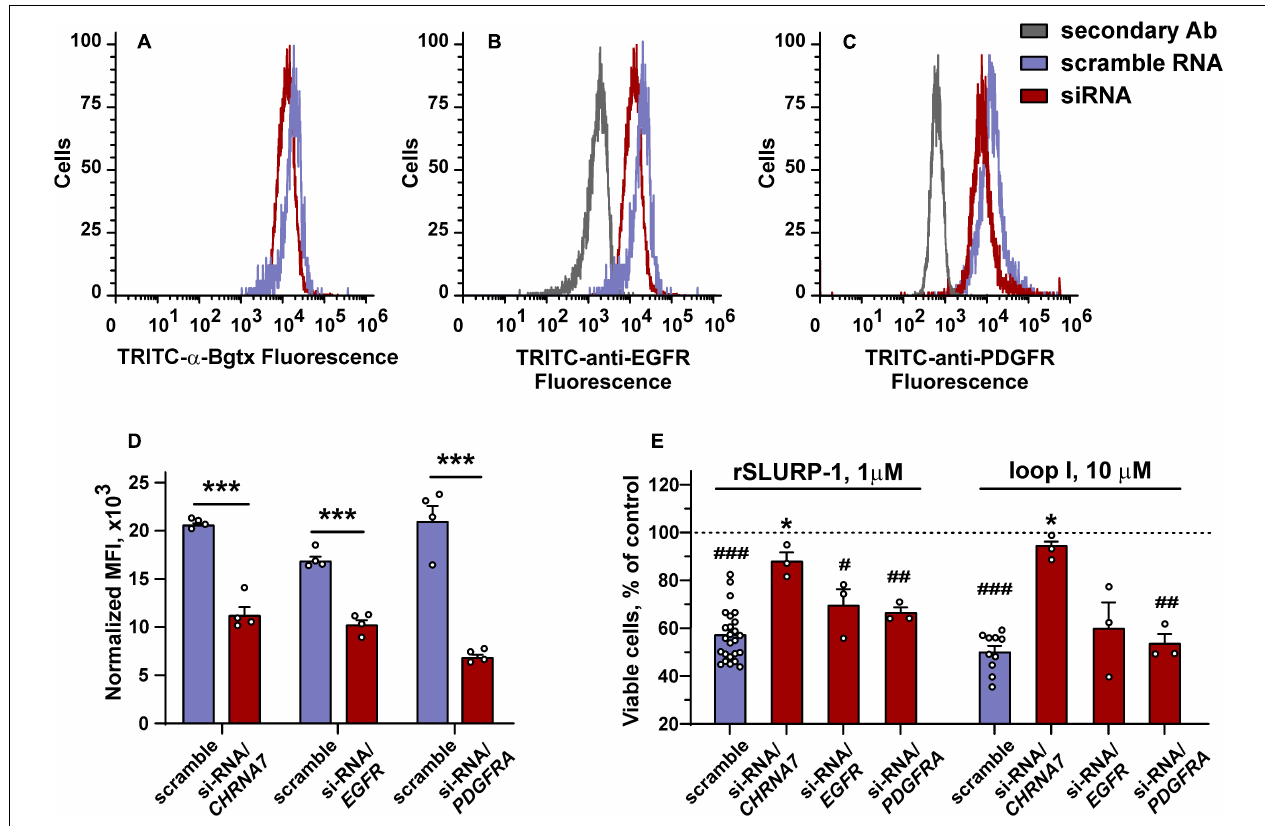
FIGURE 7 | Influence of CHRNA7 , EGFR , and PDGFRA knock-down on the rSLURP-1 and “loop I” peptide antiproliferative activity in A549 cells. (A–C) Representative histograms of the cell distribution after transfection with scramble RNA (purple) or siRNA to CHRNA7 , EGFR , or PDGFRA (red) according to the intensity of TRITC-labeled α -Bgtx (A) , TRITC-labeled antibody against EGFR (B) , and TRITC-labeled antibody against PDGFR α (C) . (D) Median fluorescence intensities for TRITC-labeled α -Bgtx, TRITC-labeled antibody against EGFR, or TRITC-labeled antibody against PDGFR α in cells transfected with scramble RNA and in cells with the blocked α 7-nAChR, EGFR, or PDGFR α expression ( n = 4). ∗∗∗ ( p < 0.001) indicates the significant difference between the groups by two-tailed t -test. (E) Influence of 1 µ M rSLURP-1 or 10 µ M “loop I” on proliferation of cells transfected with scramble RNA and in cells with blocked α 7-nAChR, EGFR, or PDGFR α expression upon 48 h incubation. Data presented as % of control ± SEM ( n = 3–25). # ( p < 0.05), ## ( p < 0.01), and ### ( p < 0.001) indicate significant difference from control (untreated cells, dashed line) by one-sample t -test. ∗ ( p < 0.05) indicates significant difference from the cells transfected with scramble RNA by one-way ANOVA/Dunnett’s hoc